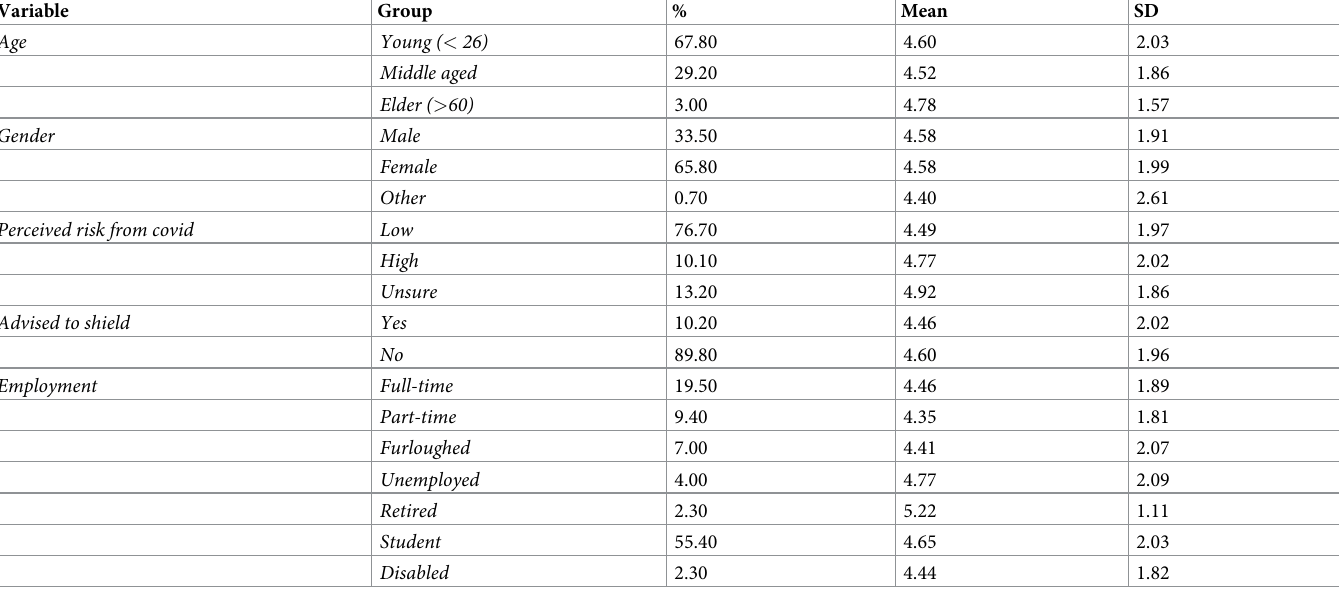
Table 1. Subjective ratings of the length of the 12 months since lockdown as a function of demographic